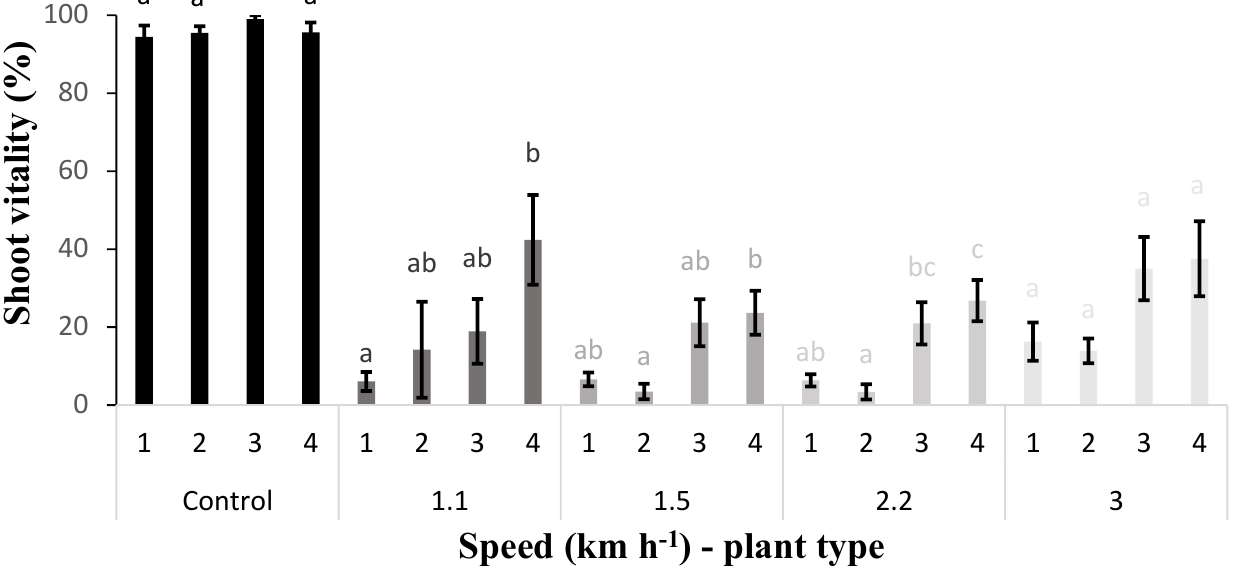
Figure 3. Shoot vitality (%) of electrocuted C. esculentus plants for each combination of speed (km·h − 1 ) and plant type in the Zasso experiment at Bree in 2021. Means sharing the same letter are not significantly different ( p < 0.05); comparison within speed only.